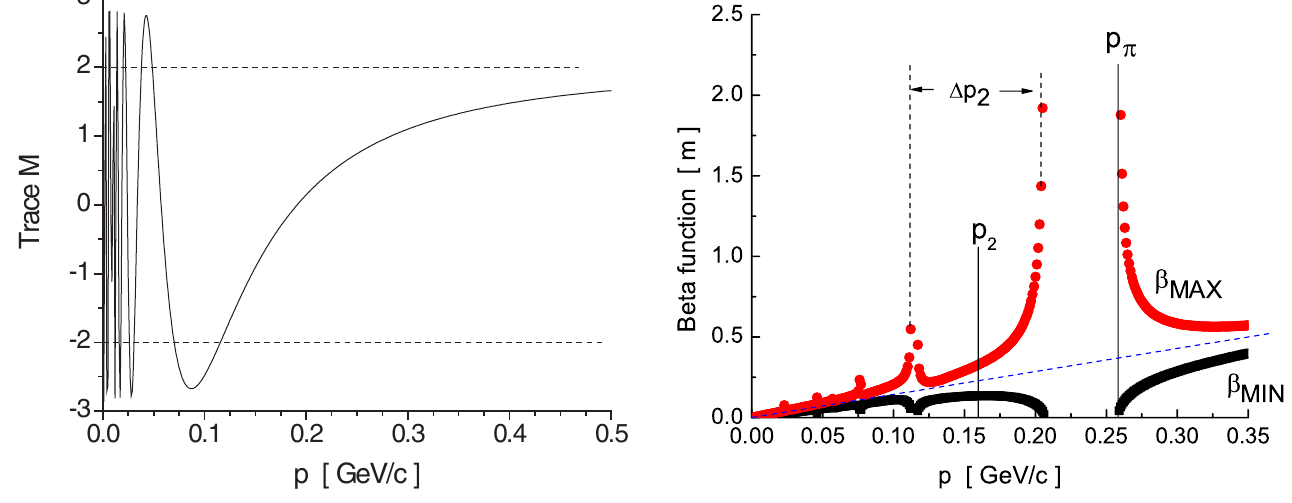
FIG. 4. (Color) Minimum and maximum values of the beta function as a function of p . The parameter values were d (cid:2) 100 cm , L (cid:2) 40 cm , a (cid:2) 40 cm , t (cid:2) 10 cm , J (cid:2) 100 A = mm 2 , and constant